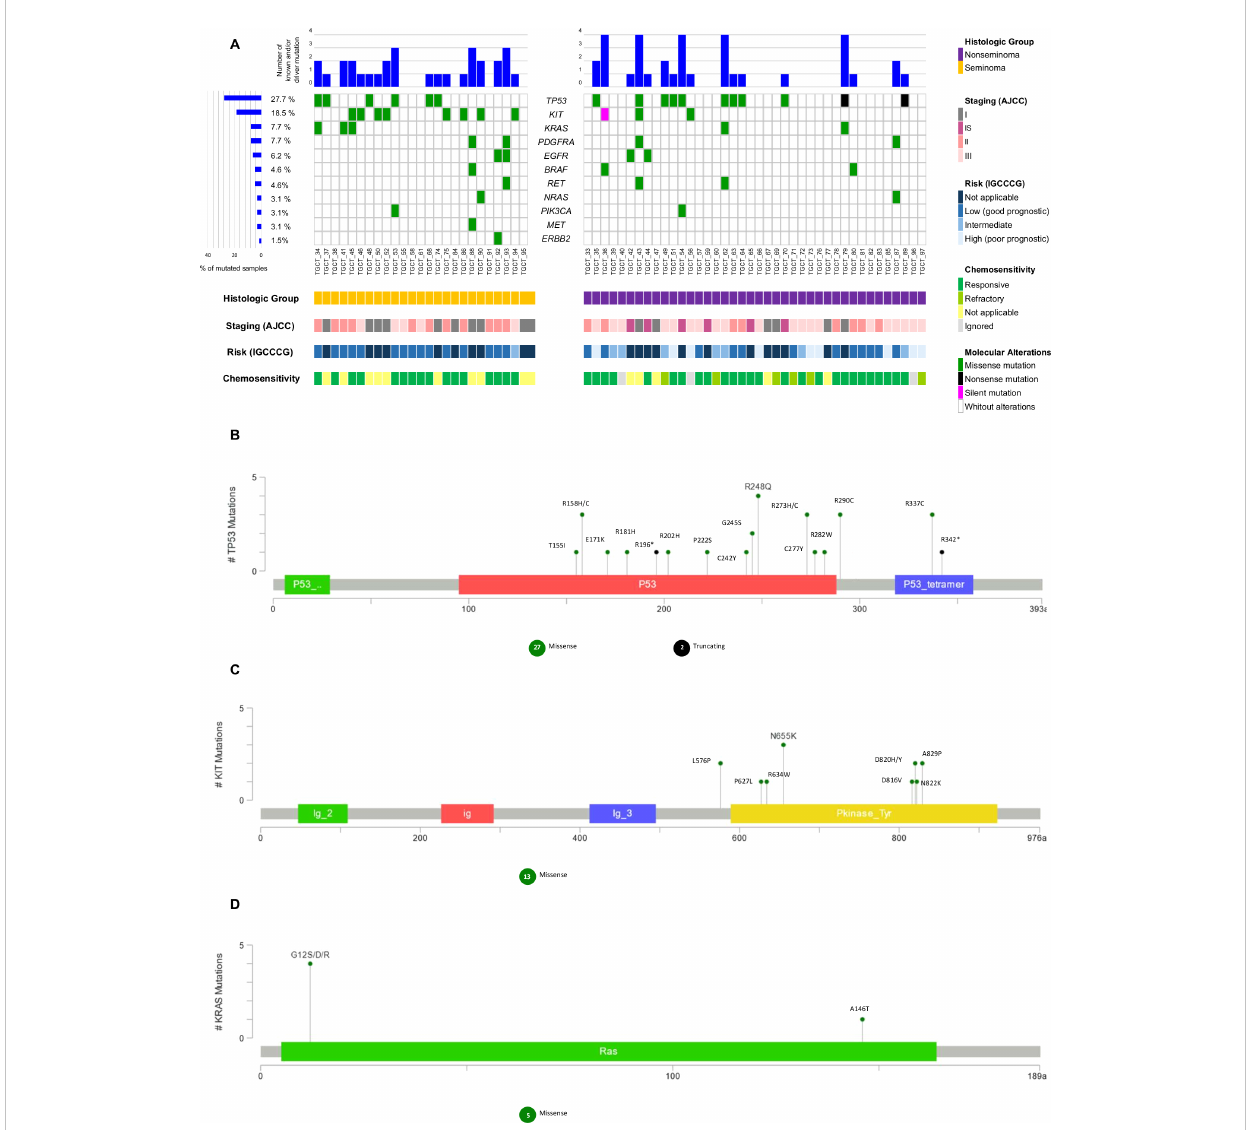
FIGURE 3 Waterfall plot of the known and/or predicted driver mutation spectrum of Testicular Germ Cell Tumor (TGCT). (A) Plots show the frequency of samples mutated for seminomas and non-seminomas. The upper panel demonstrates the frequency of mutation for each sample. The left panel shows the frequency of samples harboring mutations according to the gene. The lower panel indicates clinicopathologic data. (B) Variant distribution in TP53 gene. (C) Variant distribution in KIT gene. (D) Variant distribution in KRAS gene. All graphs depict a lollipop plot showing identi fi ed variants relative to a schematic representation of the gene. Any position with a mutation is shown with a circle, and the length of the line depends on the number of mutations detected at that codon. The grey bar represents the entire protein with different amino acid positions (aa). The colored boxes are speci fi c functional domains. On top of the lollipops, the most frequent variants are annotated as the amino acid change at that speci fi c